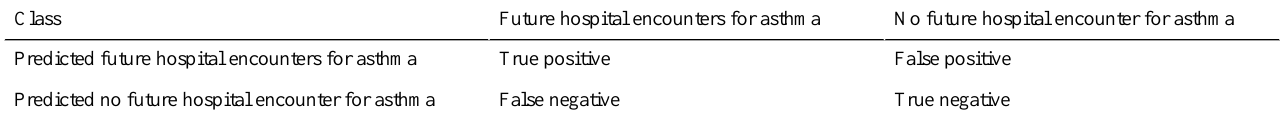
Table 1. The confusion